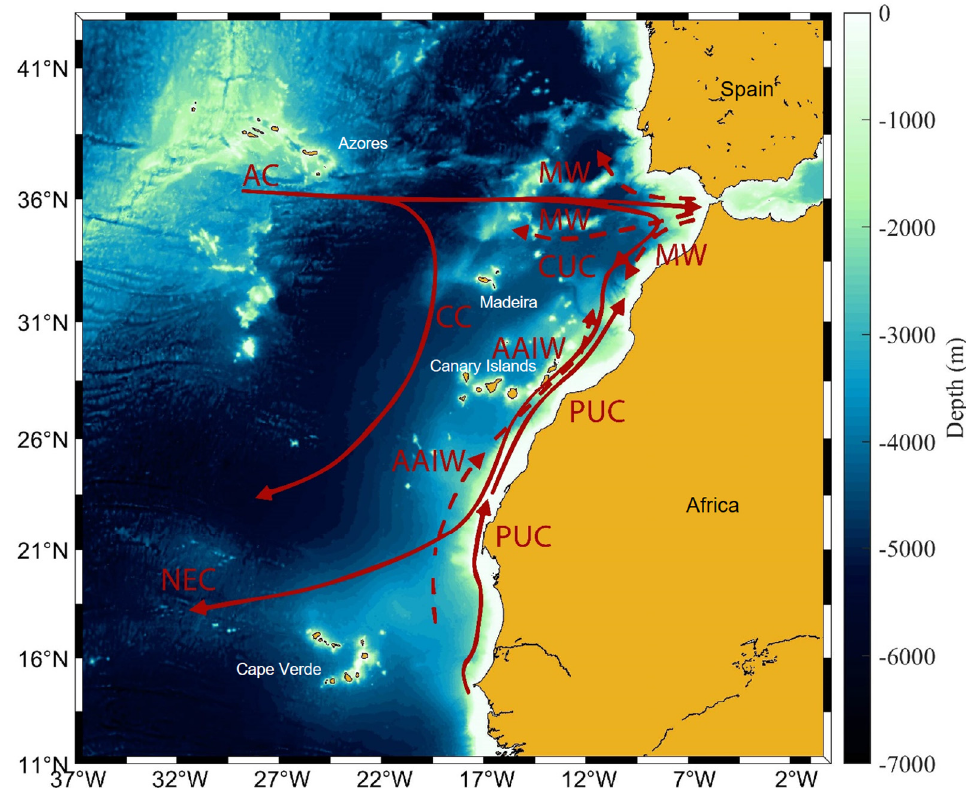
Figure 1. Scheme of the surface (solid red lines) and intermediate (dashed red lines) circulation in the Eastern Subtropical North Atlantic. Acronyms: Azores Current (AC), Canary Current (CC), Canary Upwelling Current (CUC), North Equatorial Current (NEC), Poleward Undercurrent (PUC), Antarctic Intermediate Water (AAIW), Mediterranean Water (MW).